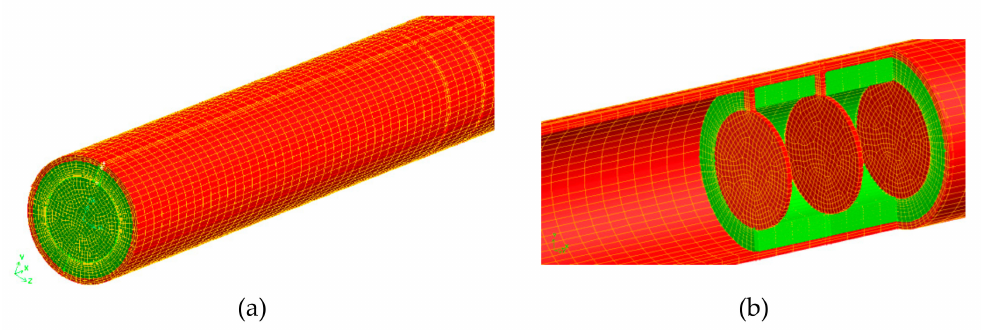
Figure 5. Three-dimensional Hexa grid use in this study. ( a ) global mesh of the absorber. ( b ) detailed mesh near obstacles.